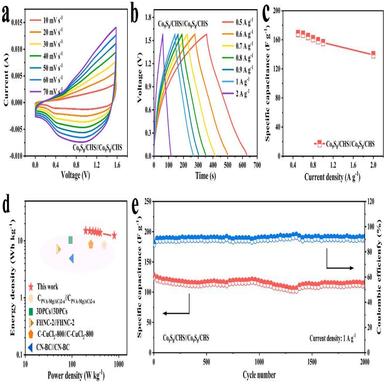
Electrochemical properties of SSC (a) CV curves; (b) GCD curves; (c) the specific capacitance; (d) Ragone plot; (e) cycling performance.